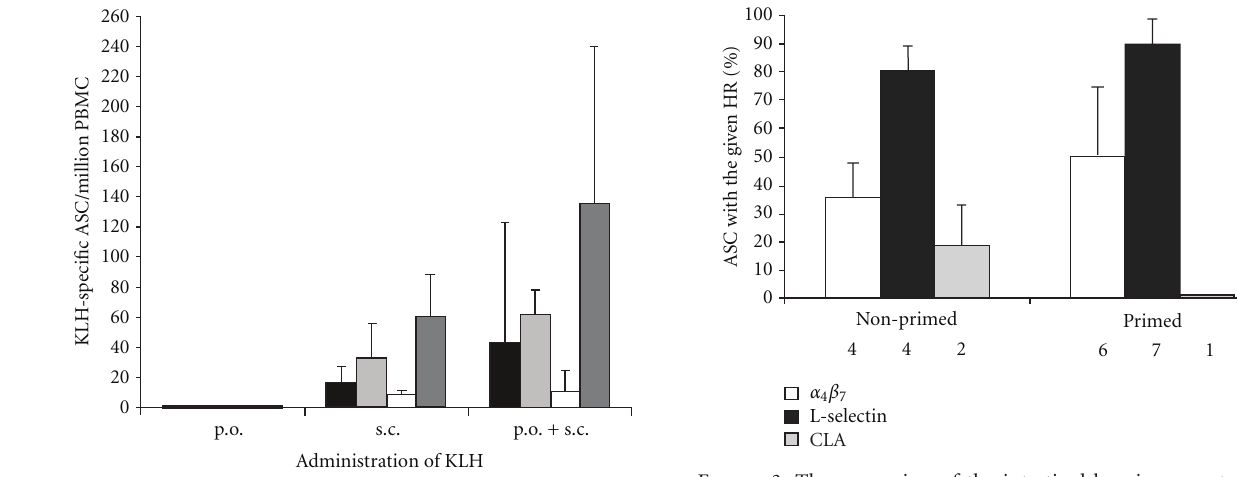
Figure 3: The expression of the intestinal homing receptor, α 4 β 7 integrin, the peripheral lymph node HR, L-selectin, and the skin HR, CLA, on KLH-specific plasmablasts after two subcutaneous KLH injections given to orally primed or nonprimed volunteers. The data were calculated by counting the proportion of HR positive cells among all cells (the sum of HR positive and negative cells). The data are given as arithmetic means of the percentage of ASC expressing the given receptor ± SD. The numbers ofvolunteers from whom the data were pooled are indicated under each